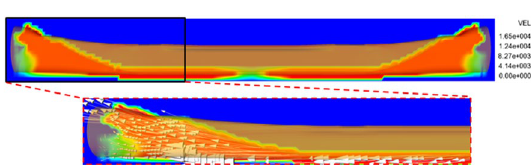
Figure 32 Cloud map of fluid velocity during sliding mold clamping closing